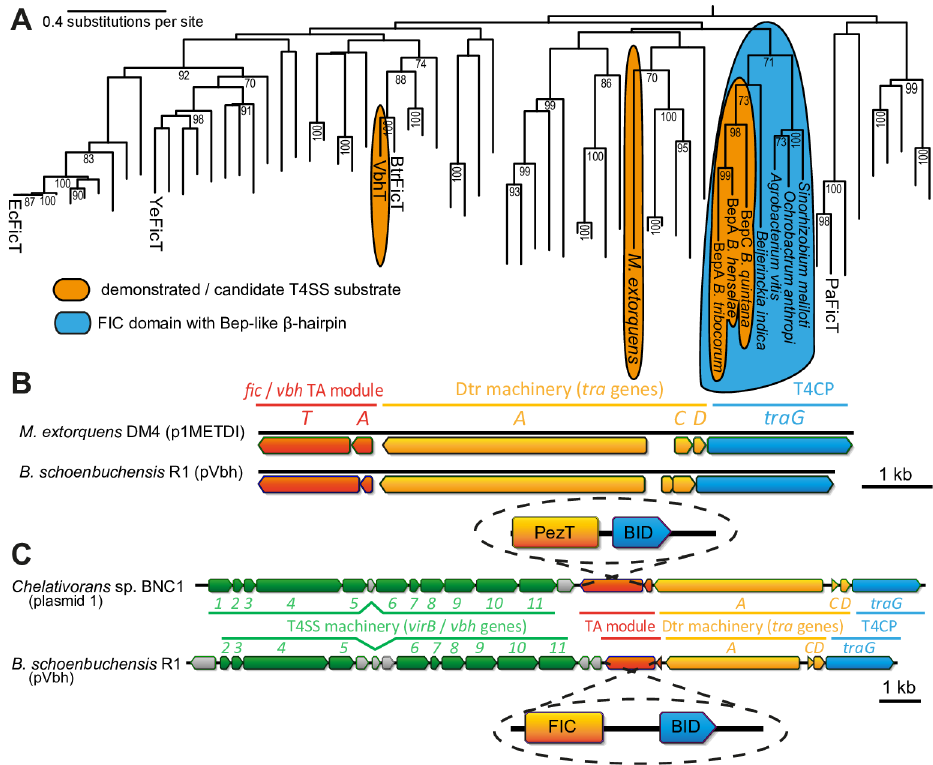
Fig 6. TA module toxins as bona fide substrates for conjugativetype IV secretion. (A) The positionof knownandproposed T4SS substratesas wellas proteinswith a Bep-like β -hairpinare highlighted in the phylogeny of FicT toxins (adaptedfrom ourpreviouswork [21];seealsoS3A–S3C Fig).In short,the tree represents a maximumlikelihoodphylogeny that hadbeenconstructed from an alignmentof the toxins’FIC domains. An additional phylogenysupportingthe repeated,independent recruitment of FicT toxins as T4SS substratesis presented in S3B Fig.FicT of M . extorquens (UniProtidentifierC7CN81(C7CN81_METED)) is shownas a candidateT4SS substratebecauseit carriesa BID-likesequenceat its C-terminus(S3CFig).(B) The geneticarrangement of vbhAT at the Dtr locusof pVbhof B . schoenbuchensis R1 was compared to the locusencodingthe FicTA moduleon p1METDI of M . extorquens DM4 (genbankaccessionnumberNC_012987). (C) The illustration showshowa PezTA moduleon Chelativorans sp. BNC1plasmid1 (genbankaccession numberCP000389.1)is encodedbetweenthe conjugativeVirB T4SS andits Dtr machinery in the samegenetic arrangement as the VbhTAmoduleis encodedon pVbh.